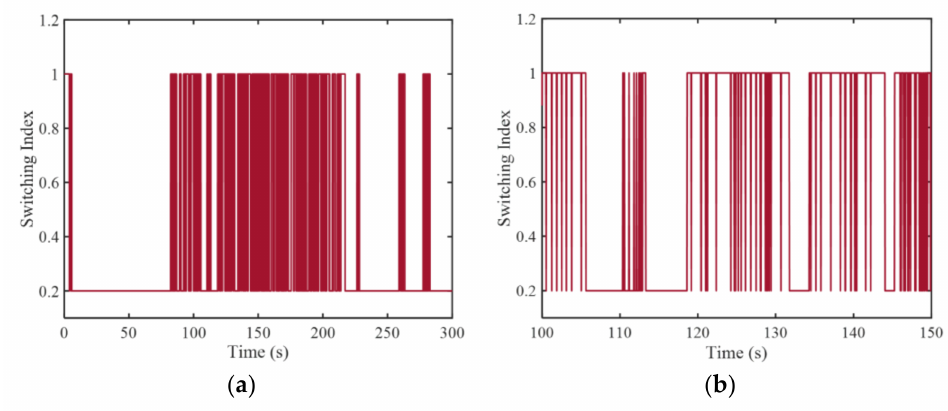
Figure 9. Switching index of the proposed controller: ( a ) general view, ( b ) enlarged